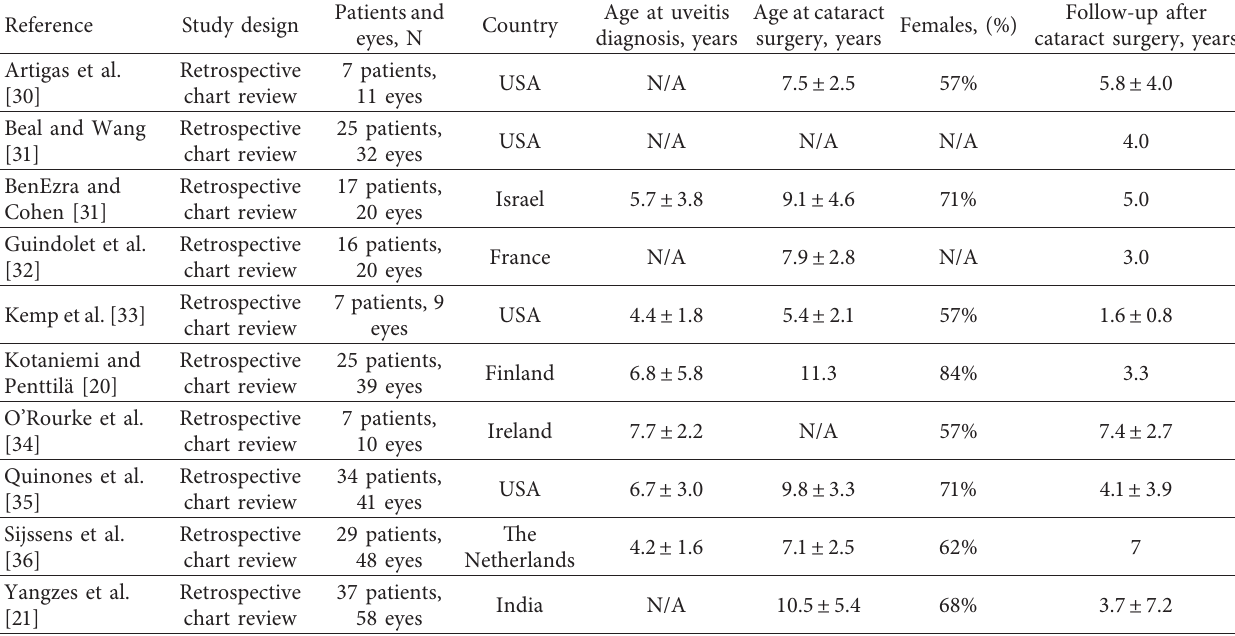
Table 1: Characteristics of the included studies.